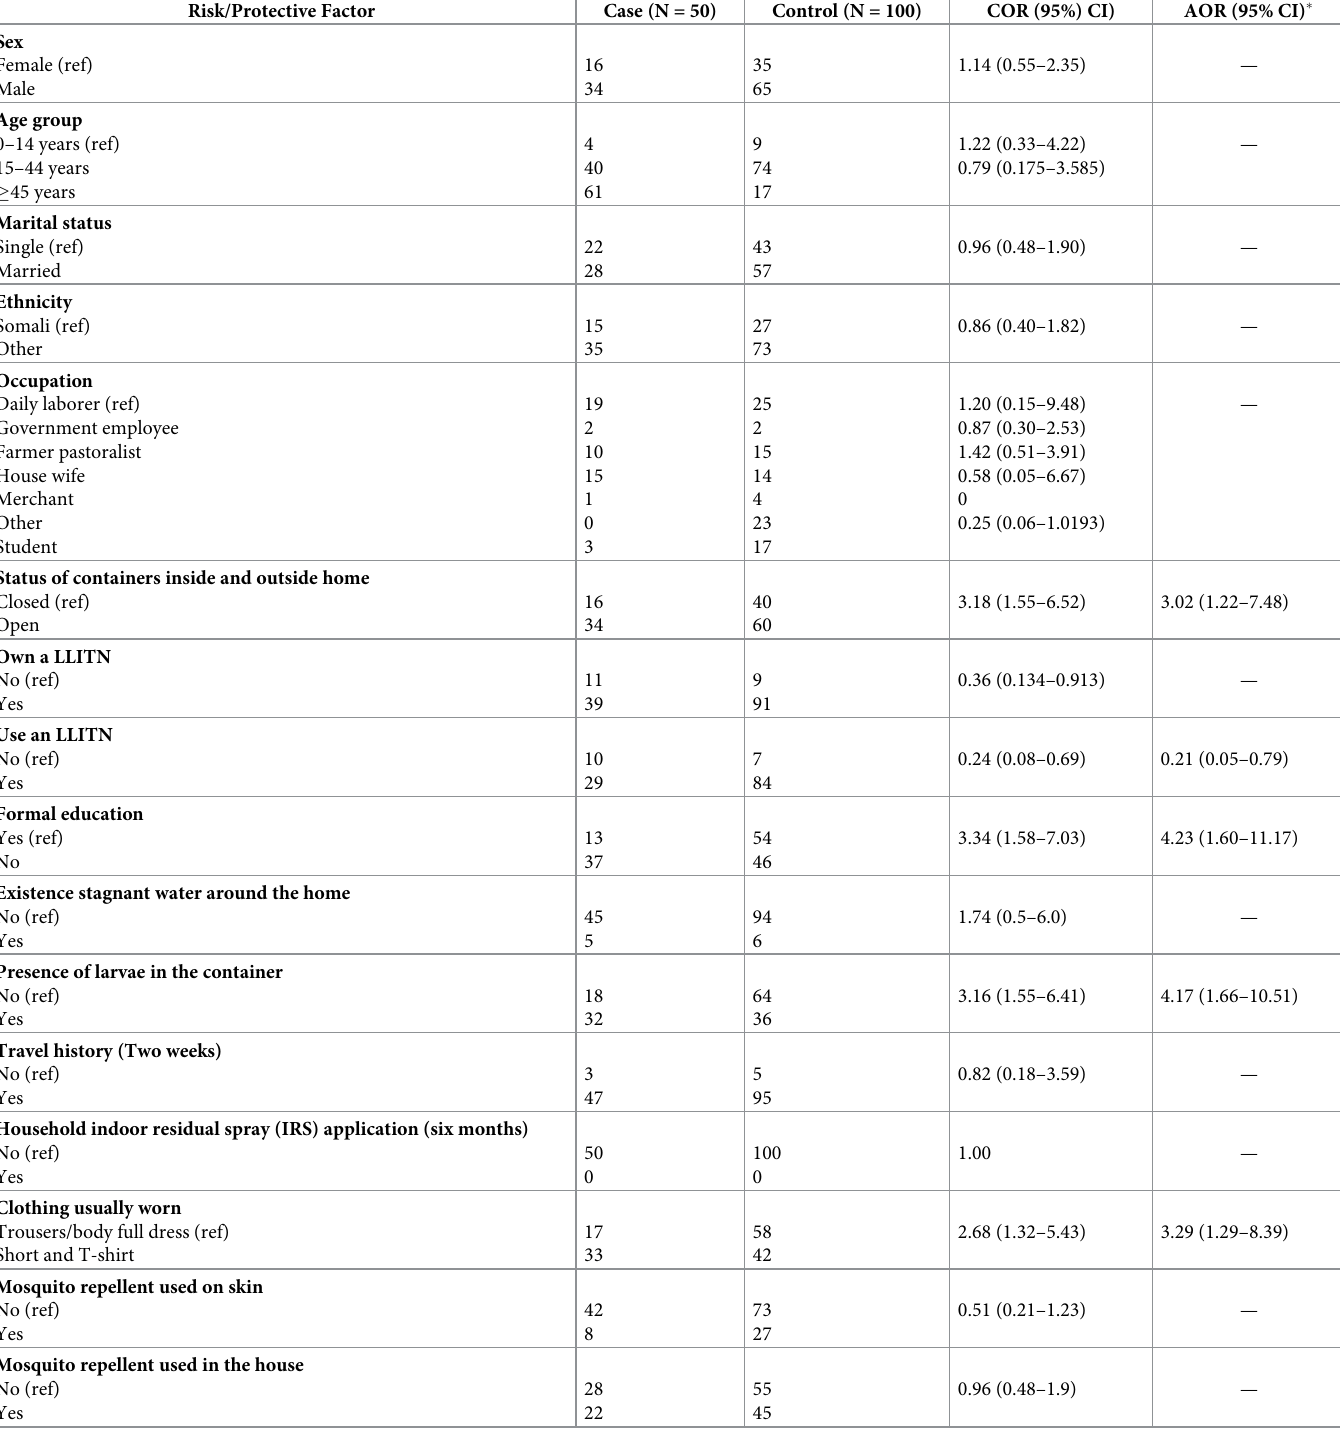
Table 1. Bivariate Conditional and Multivariable Logistic Regression Analysis: Socio-demographic Characteristics and Potential Risk and Protective factors for Dengue Fever (DF)—Kabridahar District, Korahay Zone, Somali region, Ethiopia, 2017. Risk/Protective